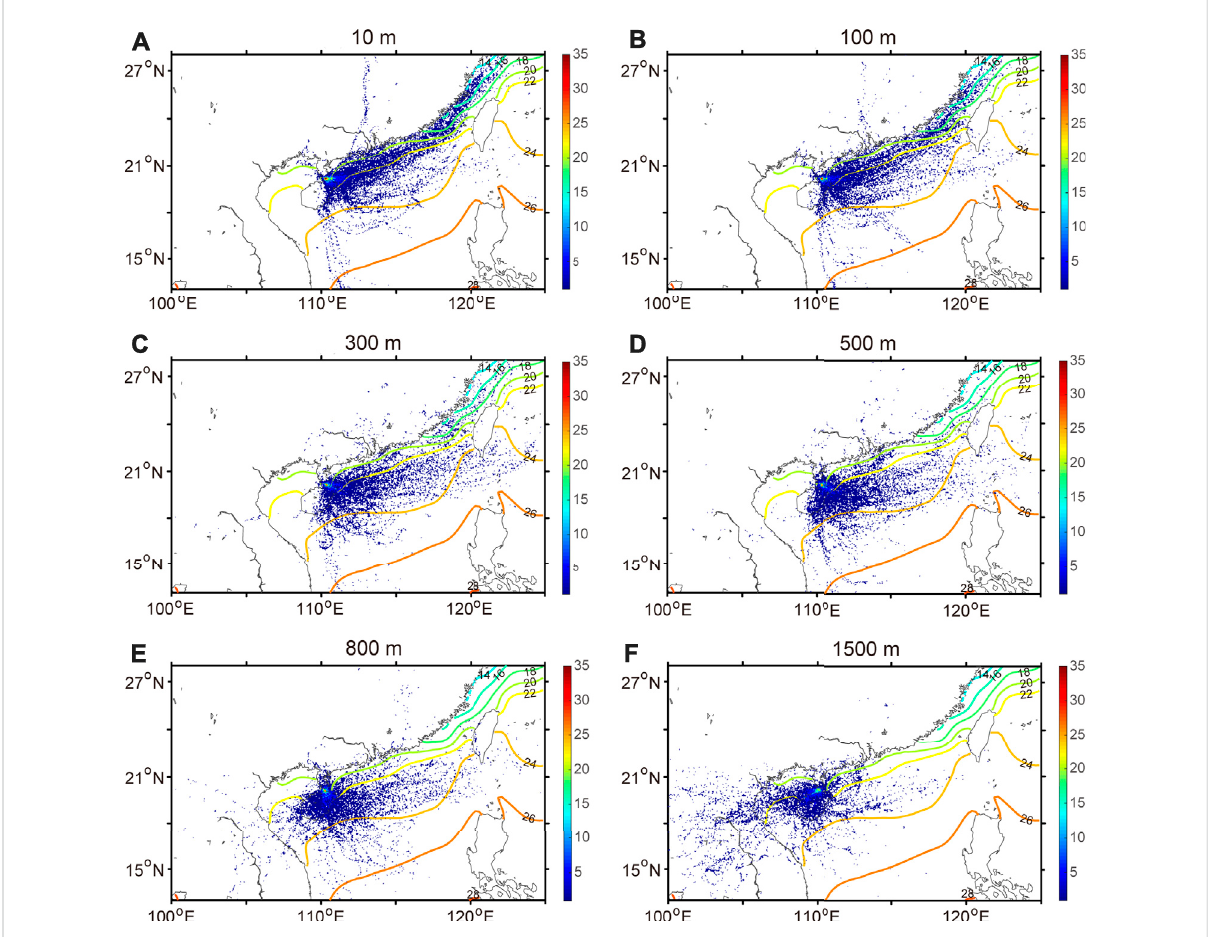
FIGURE 2 Numberof72 hbackwardtrajectoriesforeachlevelatXuwenharborduringallseafogeventsin2013 – 2021. (A – F) represents10,100,300,500, 800, and 1500 m of the trajectory above sea level. Scale is number passing over a given gridpoint out of the 456 runs. Contours show the climatological mean of January – March SST for 1982 – 2021 ( °